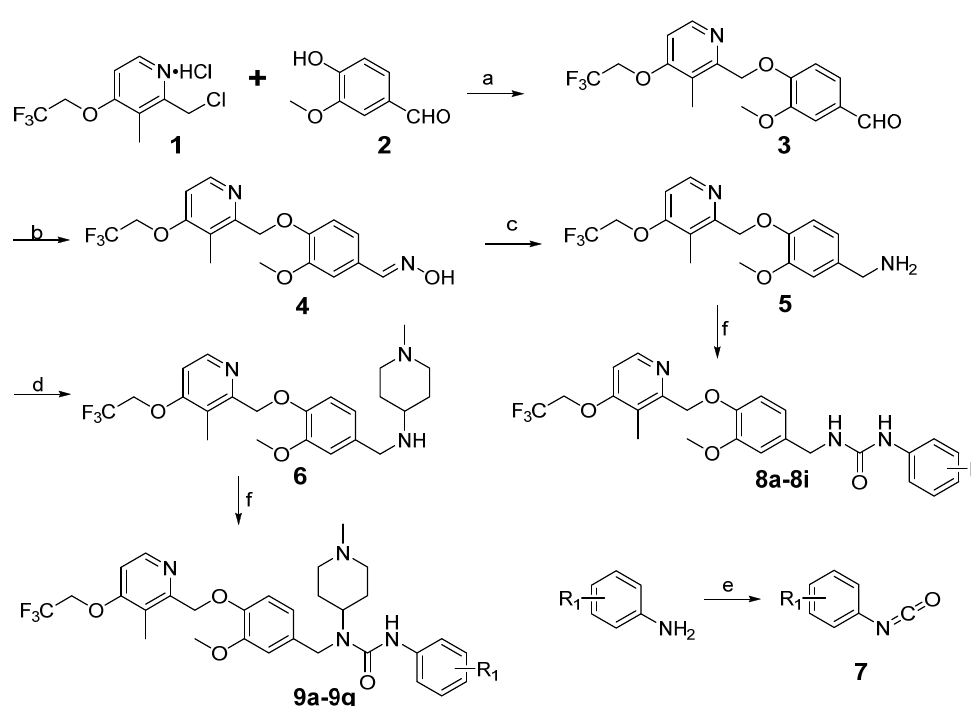
Table 1. The chemical structures and inhibitory activities of the target compounds.